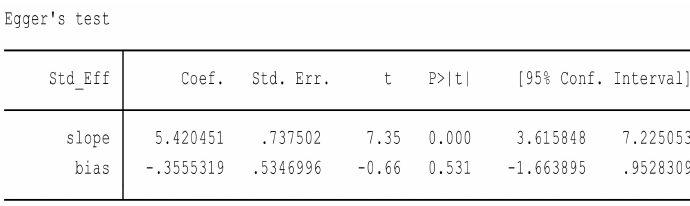
Figure 8. Eggers regression test to test hypothesis 1.